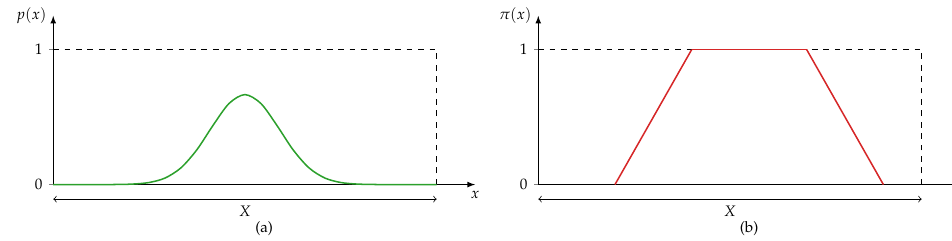
Figure 6. A continuous probability ( a ) and a continuous possibility distribution ( b ). The proba- bility distribution models a random phenomenon quantitatively; the possibility of distribution of incomplete information qualitatively. The following applies: π ( x ) p ( x ) ≥